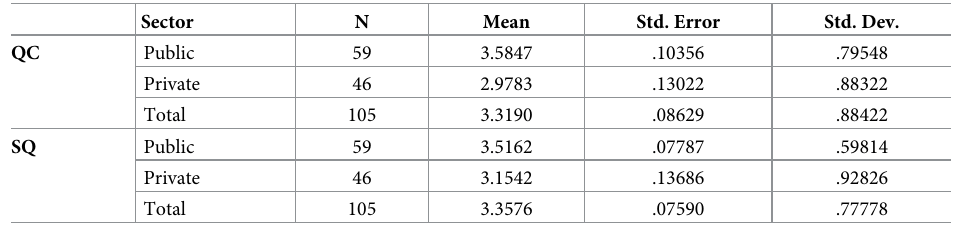
Table 5. Sector wise mean scores of QC and